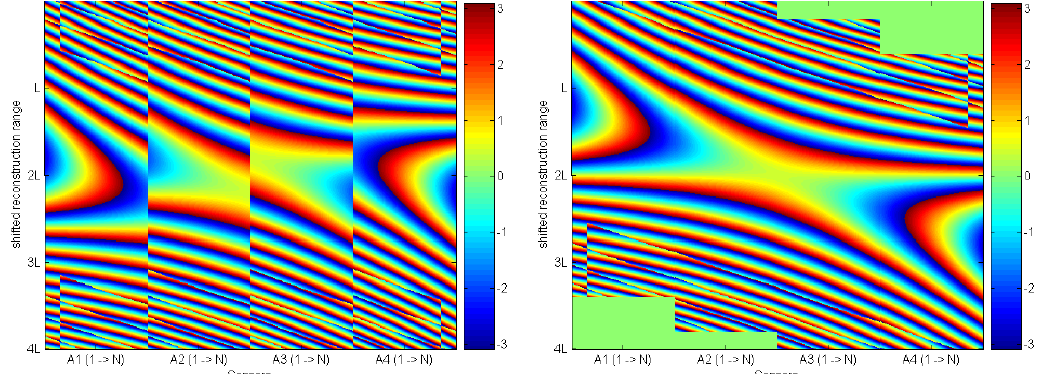
Figure 6. Phase relation of all sensors at a depth of 10 m from a point-scatterer (placed at 10 m). The y-axis shows the relation along the lateral range of four array lengths. The x-axis shows an SAS configuration of adjacent arrays.